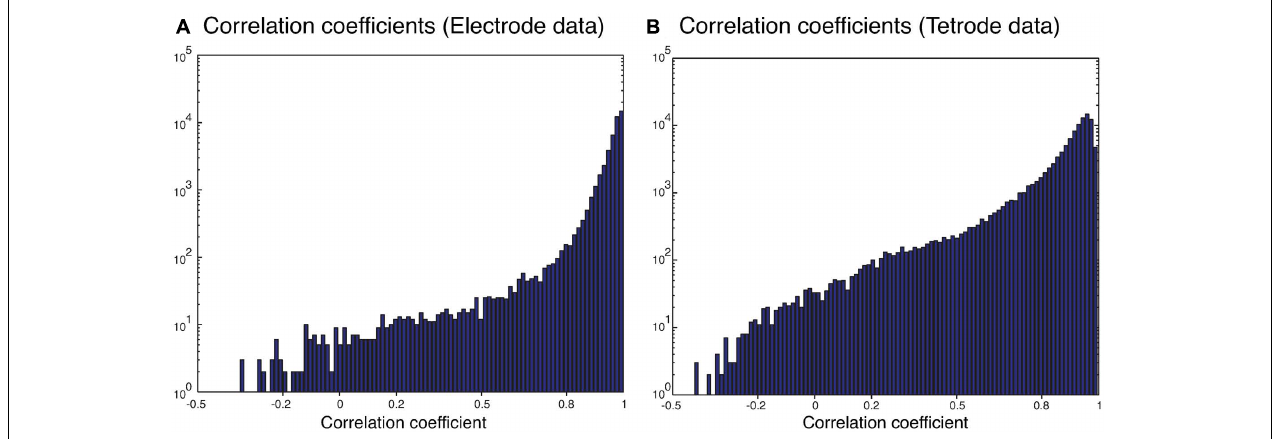
FIGURE 7 | Correlation coefficients of the best matching synthetic waveforms to the overlapping waveforms. (A) Results from electrode data. (B) Results from tetrode data. Note the log-scale on the vertical